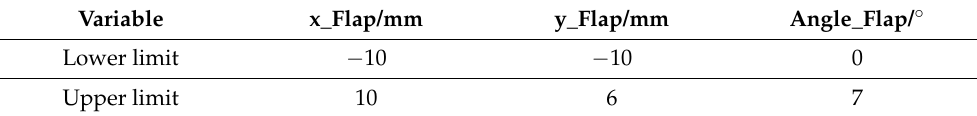
Table 3. Design space.